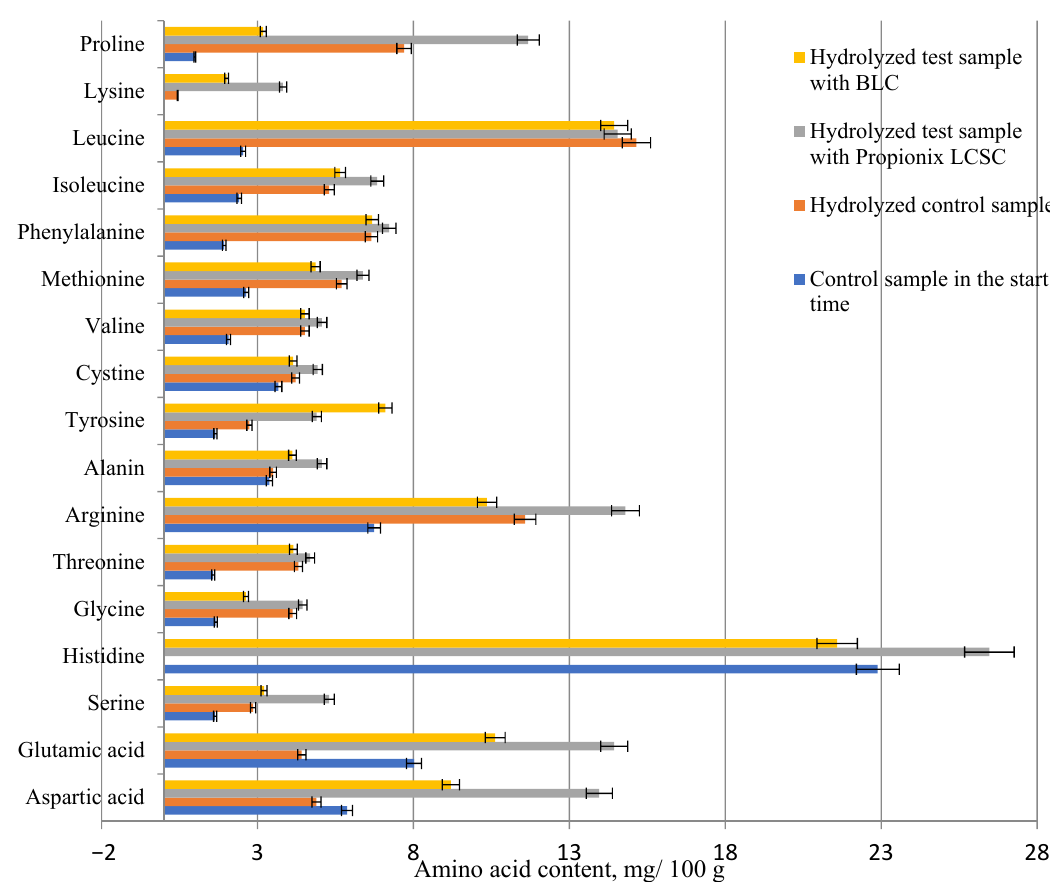
Figure 7. The results of the amino acids composition evaluation of hen gizzards hydrolysates (mg AA/100 g of hydrolysate).